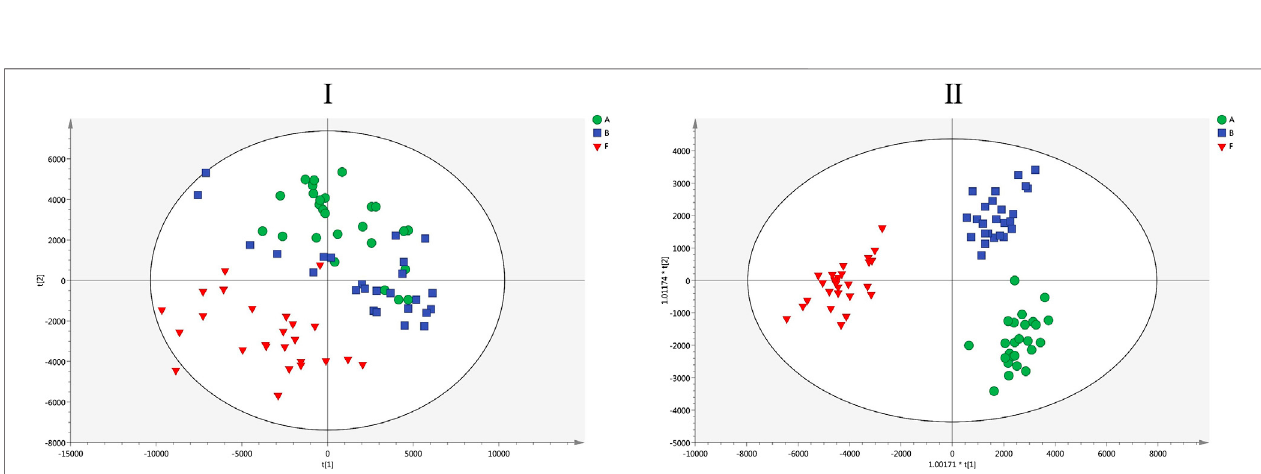
FIGURE5| ThescoreplotsofPCA(I)andOPLS-DA(II)modelsfortheuntargetedlipidomics analysis.I:R2XandQ2valuesofthePCAmodelare0.741and0.544, respectively; II: R2Y and Q2 values of the OPLS-DA model are 0.985 and 0.963, respectively. Green circles, blue squares and red inverted triangles denote groups control (A) , LPS (B) and LPS + H-HSW (F) , respectively.